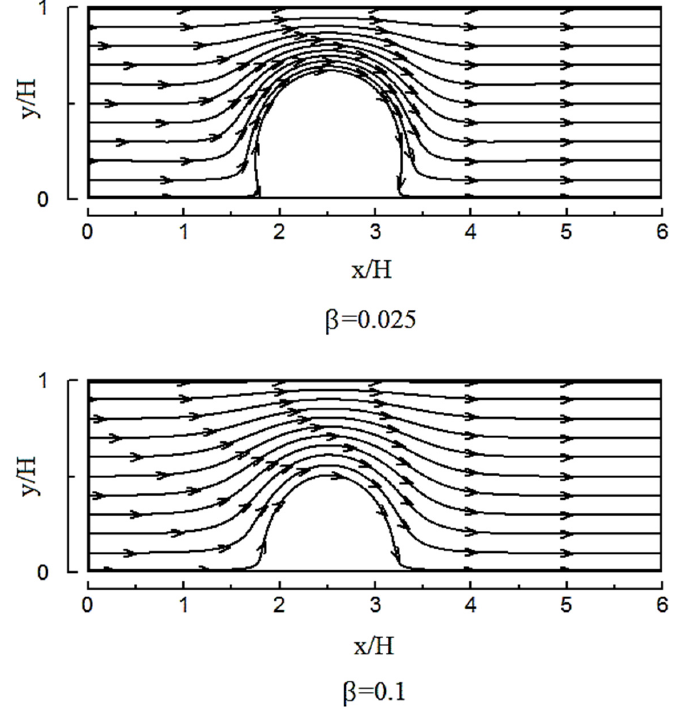
Figure 12. Streamlines for a heterogeneous microchannel with a heterogeneity patch for two slip coefficients of 0.025 and